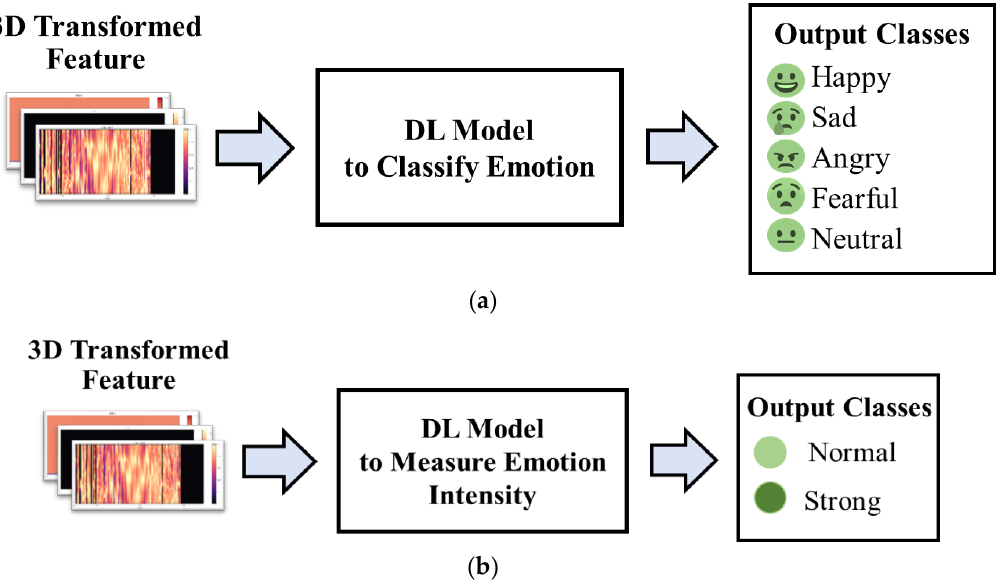
Figure 4. Cascaded DL framework to classify emotion and its intensity from 3D transformed speech signal in two different stages. ( a ) Stage 1: Classify emotion from 3D transformed feature; ( b ) Stage 2: Measure intensity for emotion classified in Stage 1.